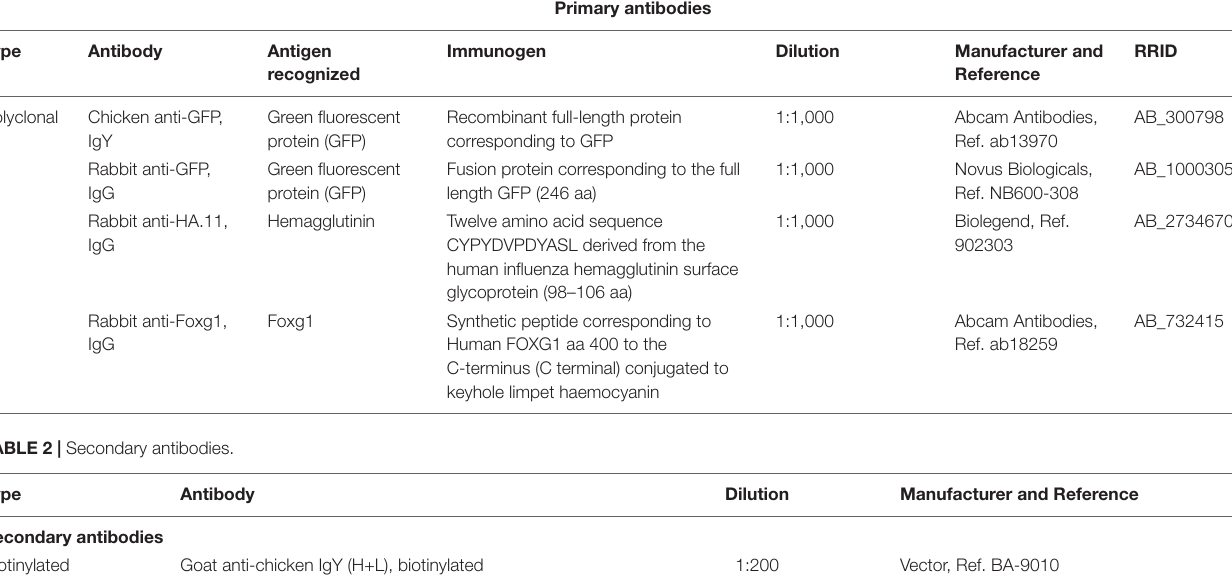
TABLE 1 | Primary antibodies.